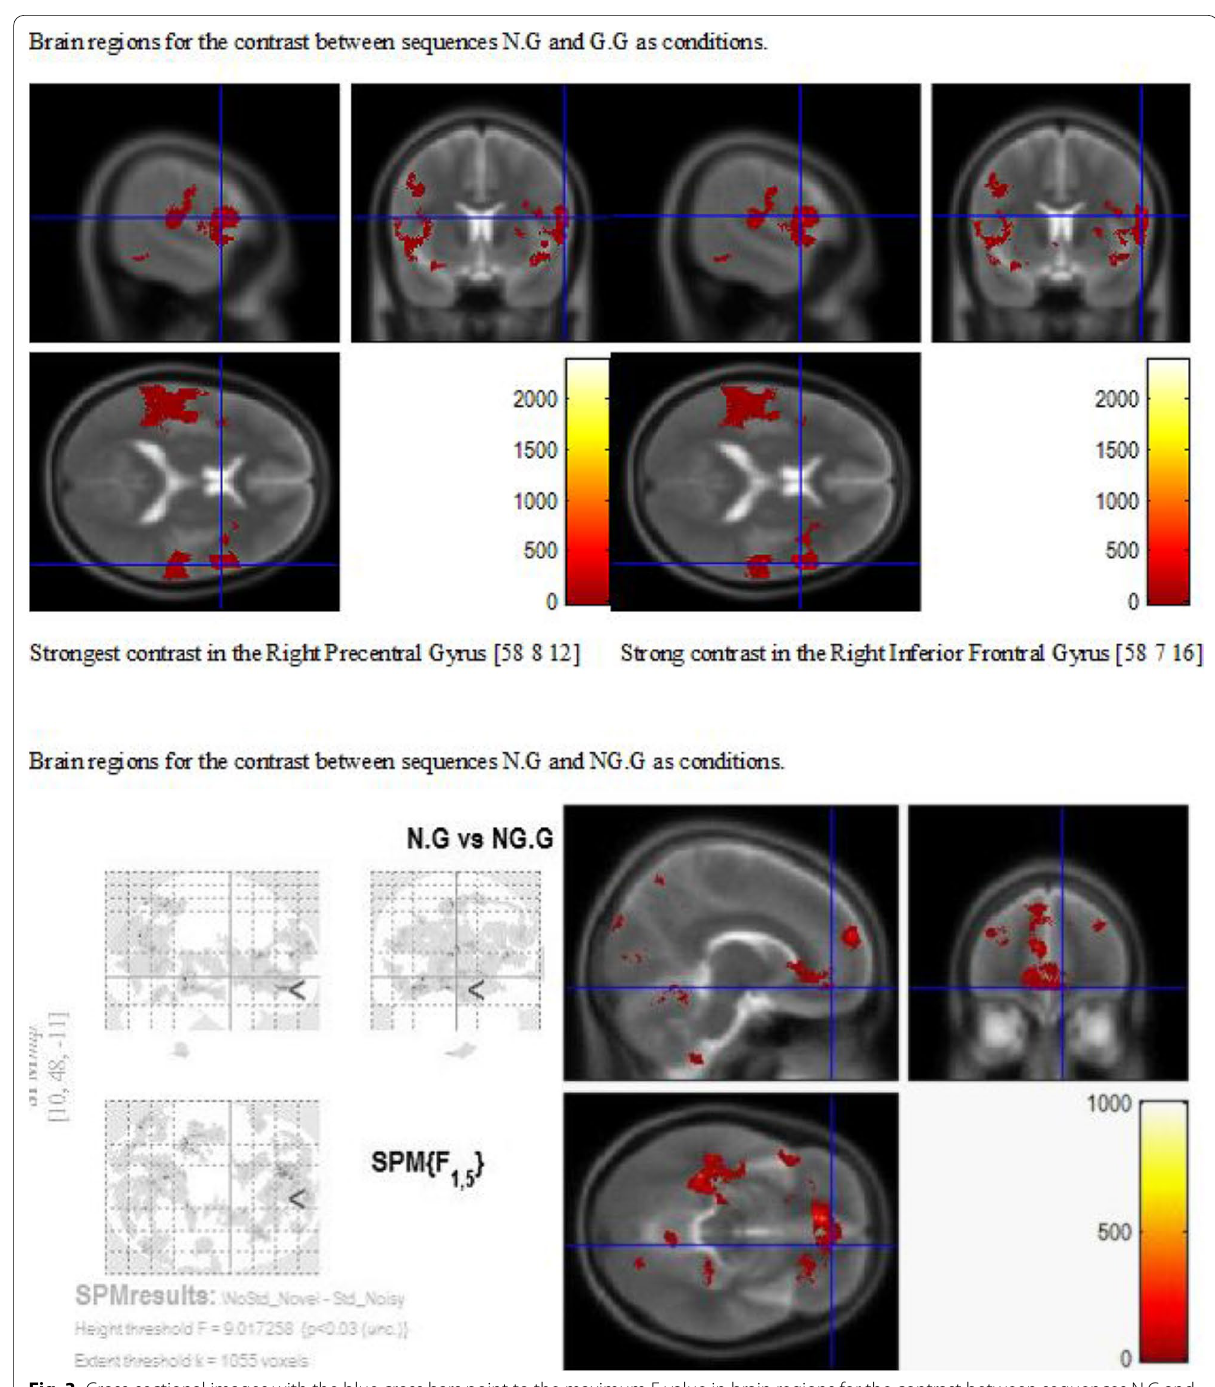
Fig. 3 Cross‑sectional images with the blue cross bars point to the maximum F value in brain regions for the contrast between sequences N.G and G.G as conditions on the top and sequences N.G and NG.G as conditions on the